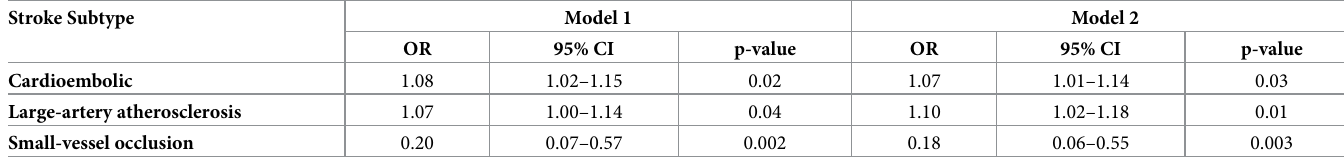
Table 2. Multivariable logistic regression demonstrating the adjusted odds ratio (OR) of each specified stroke subtype per 5 mL increase in ischemic stroke infarct volume (N = 150). Stroke Subtype